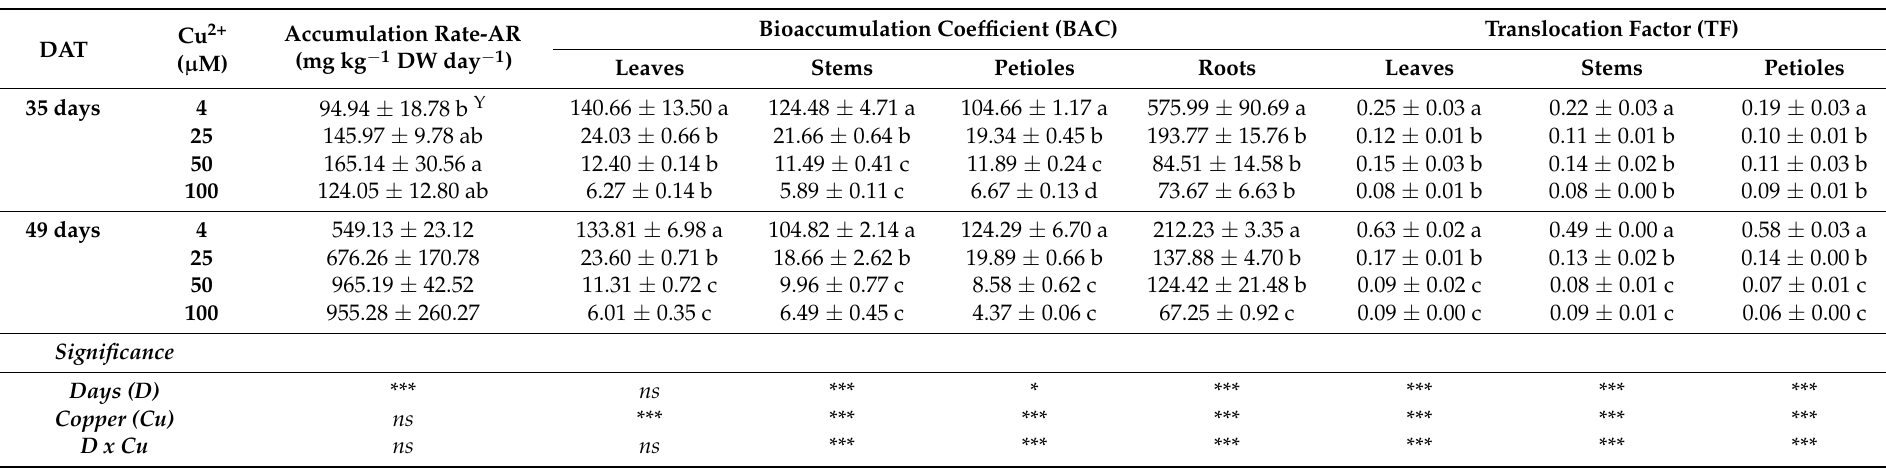
Table 3. Accumulation rate (AR, mg kg − 1 DW day − 1 ), bioaccumulation coefficient (BAC), and translocation factor (TF) for Cu after 35 and 49 DAT in pelargonium plants grown hydroponically in perlite.